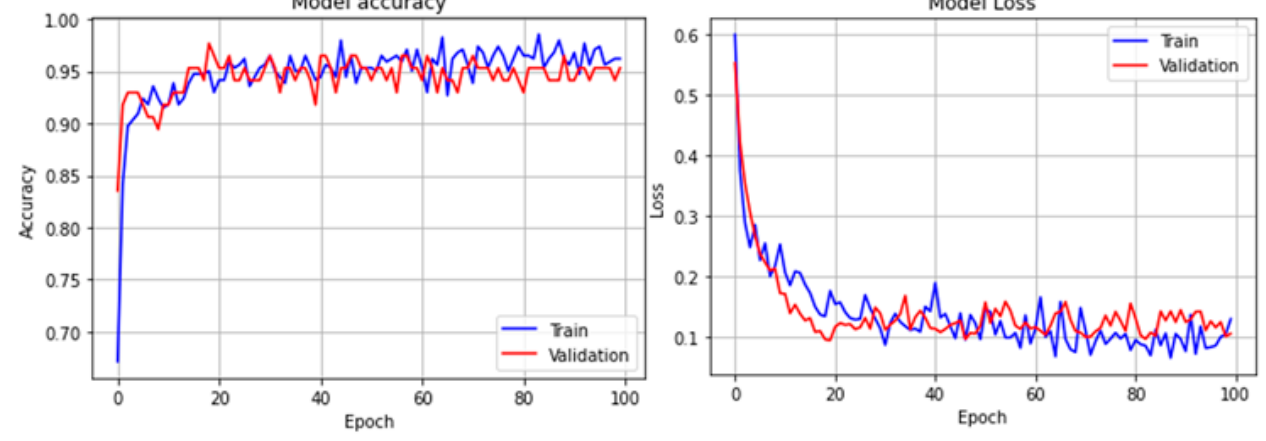
Figure 13. Accuracy and loss plots of DNN model.